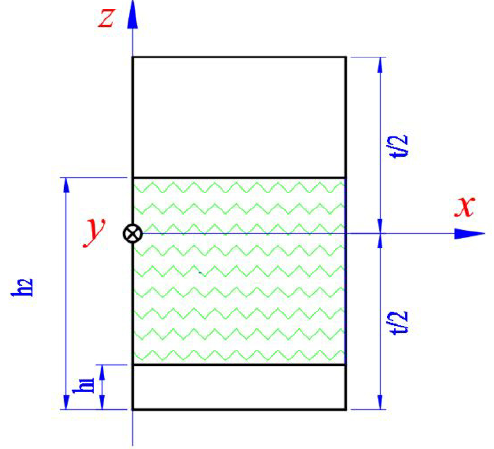
Figure 3. The laminate with embedded wrinkles.